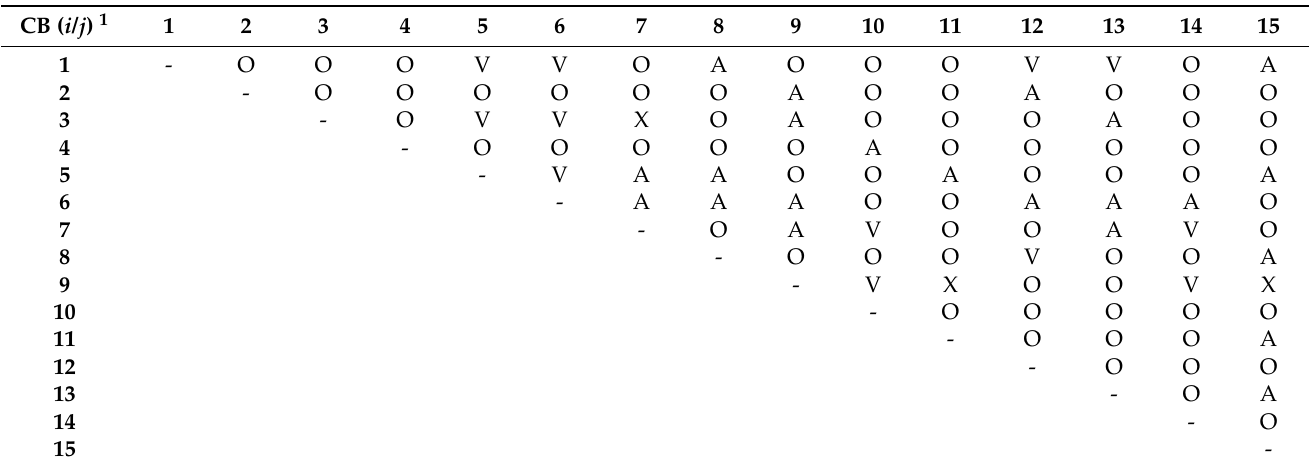
Table 4. Structural self-intersection